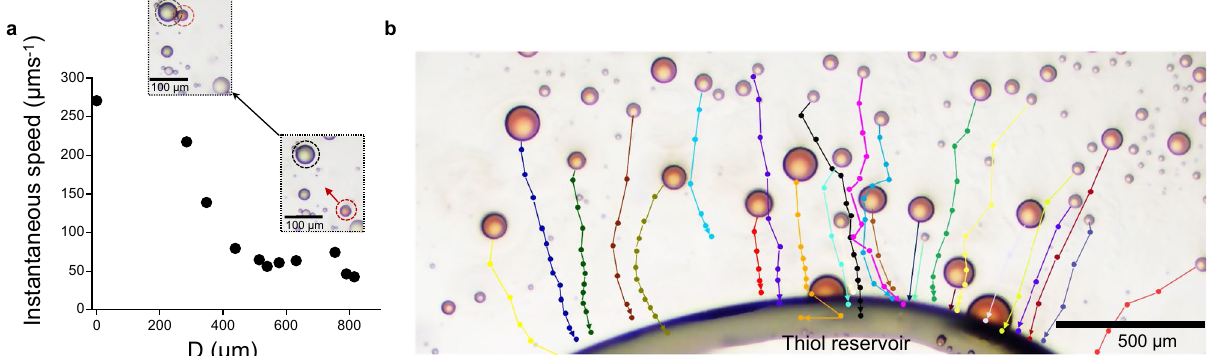
Fig. 5 Chemotactic behavior of octanol droplets. a Instantaneous speed of an ~50 µ m octanol droplet as it moves towards a reservoir of lipid precursor (1- hexanethiol), along a gradient in micellar concentration. The distance between the octanol droplet and the reservoir is noted D. All droplets displayed chemotactic behavior. b Chemotactic movement of polydisperse octanol droplets towards a thiol reservoir (Supplementary Movie 5). This experiment was repeated three times independently.